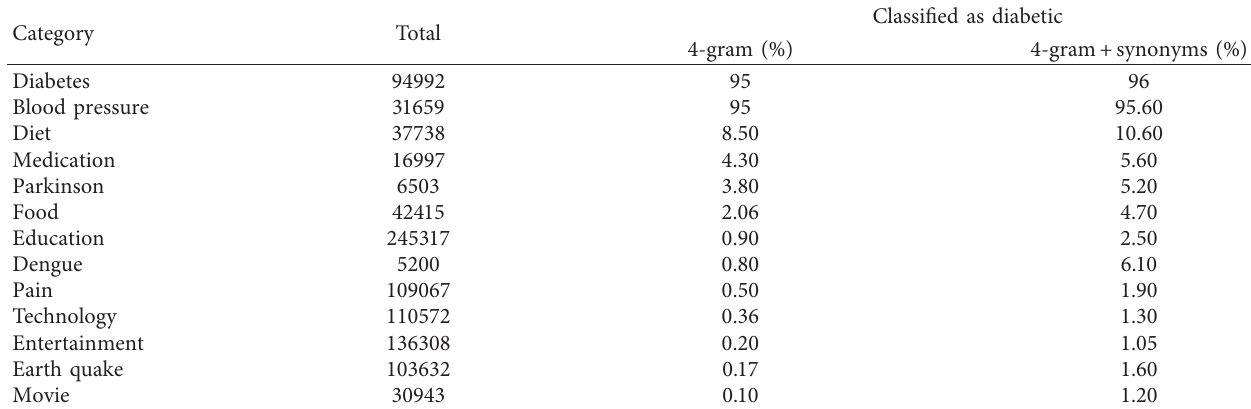
Table 2: Diabetic tweets